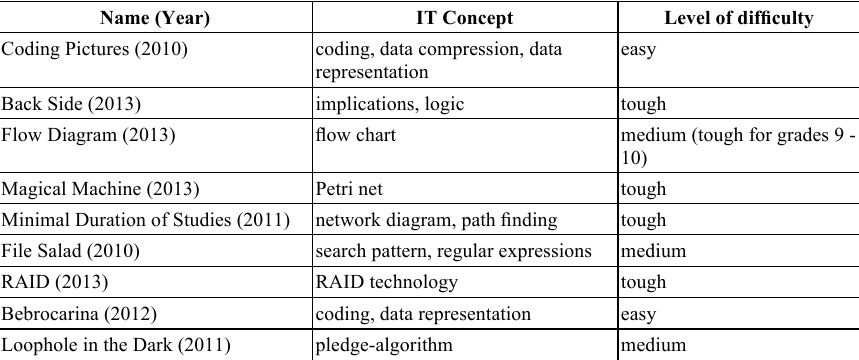
Table 3. IT concepts represented in each task and level of difficulty